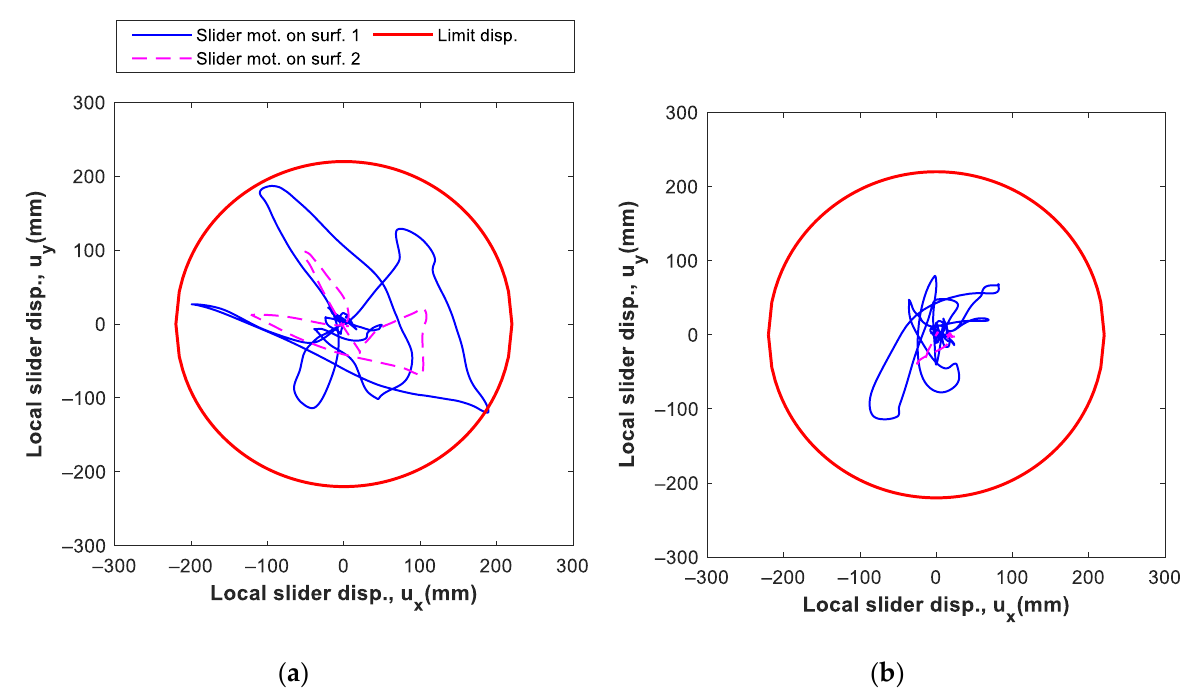
Figure 12. The movements of the pendulum on the sliding surfaces: ( a ) the near-source earthquake and ( b ) the far-field earthquake.